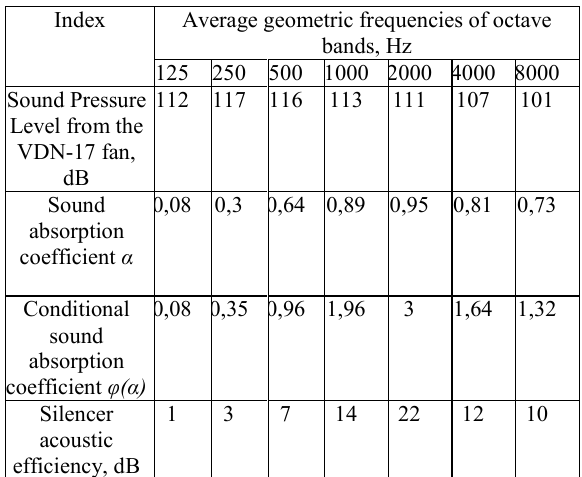
Table 4. The results of calculating the effectiveness of measures to install a silencer made of basalt fiber in